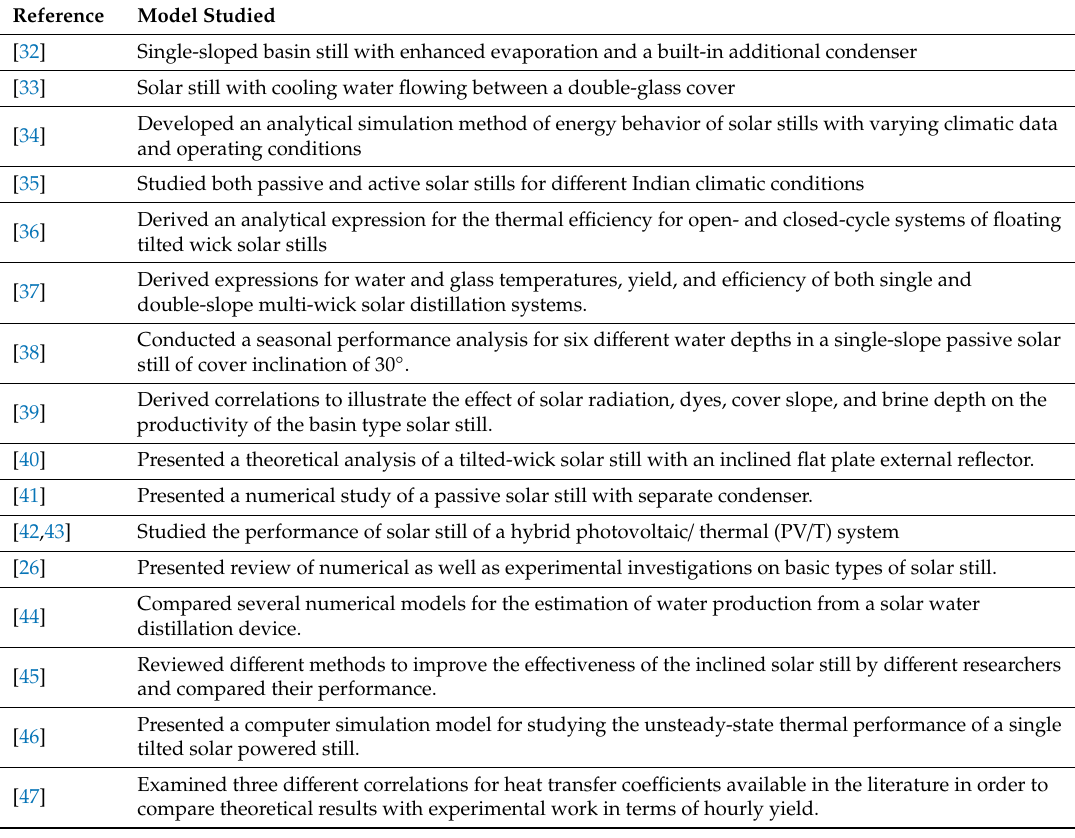
Table 1. Existing theoretical analyses for di ff erent configurations of solar